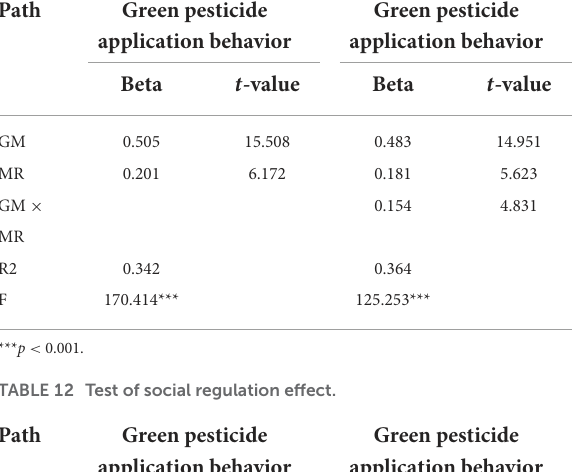
FIGURE4 Regulatory effect test of government regulation and guidance.